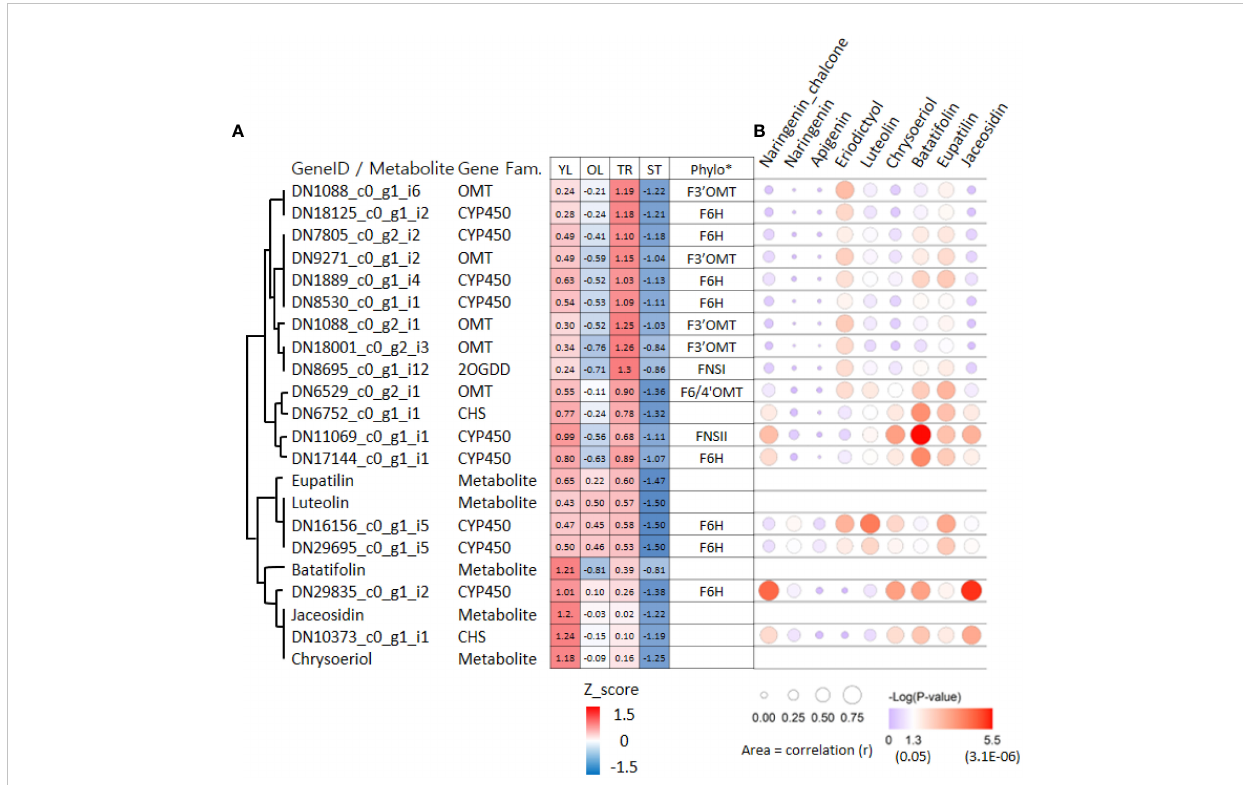
FIGURE 6 Hierarchical clustering heat map and bubble plots of putative key genes for jaceosidin and eupatilin biosynthesis. (A) Hierarchical clustering heat map of 17 genes and 5 metabolites derived from ‘ cluster 9 ’ of Figure 4. Phylo* indicates putative functions of genes inferred through phylogenetic tree analysis (Figure 5A, 5B). Z-score calculated based on Log 2 (normalized count +1) or Log 2 (amount of metabolite+1). (B) Bubble plots showing an association between gene and 9 metabolites derived from Weighted gene co-expression network analysis (WGCNA). YL represents young leaves, OL represents old leaves, TR represents trichomes, and ST represents trichome-removed stem. The bubble plot shows the strength of the correlation (r) between two variables, represented by the size of each bubble. Larger bubbles indicate stronger correlations. The color of each bubble indicates the associated